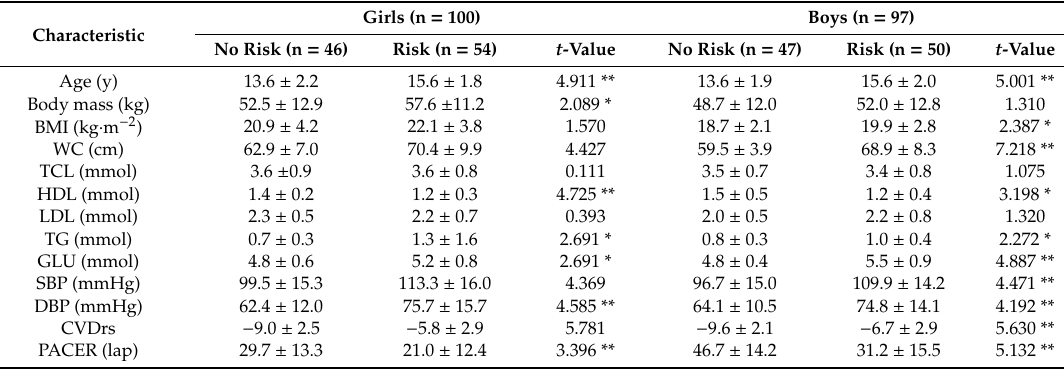
Table 4. Characteristics of participants according to presence of CVD risks (n =